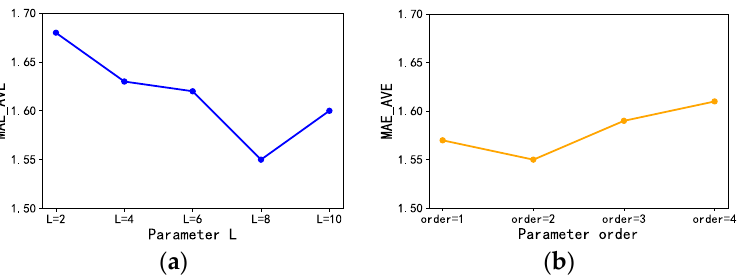
Figure 11. The average value of MAE when the parameter takes different values. ( a ) Parameter 𝐿 ; ( b ) parameter order.